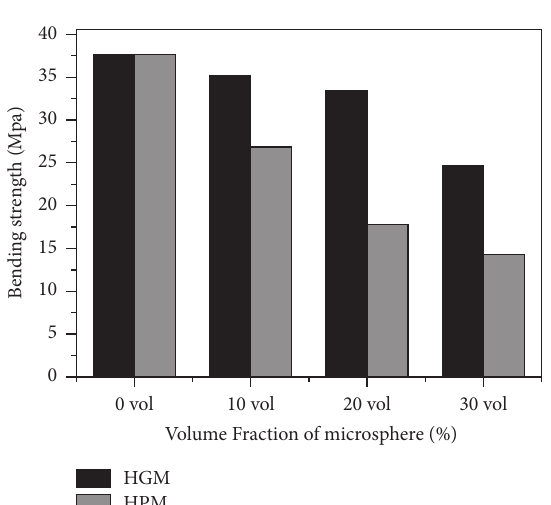
Figure 10: The specific strength of HGM/phenolic syntactic foam and HPM/phenolic syntactic